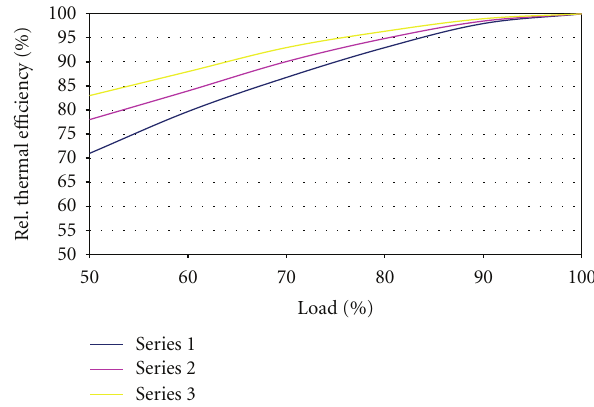
Figure 6: Averaged load variation for four stations of an interstate pipeline in South America during summer and winter scenarios.